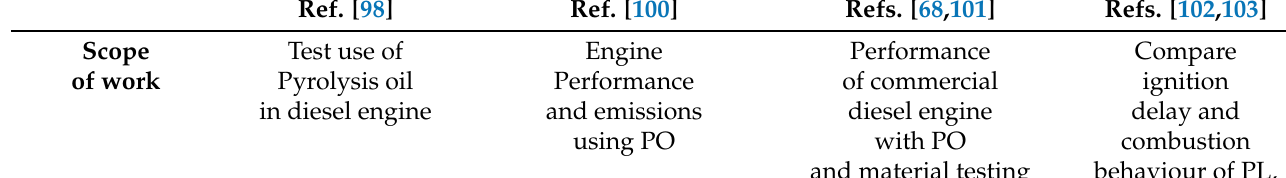
Table 5. Experimental work reported using biomass pyrolysis oil (PO) for diesel engine